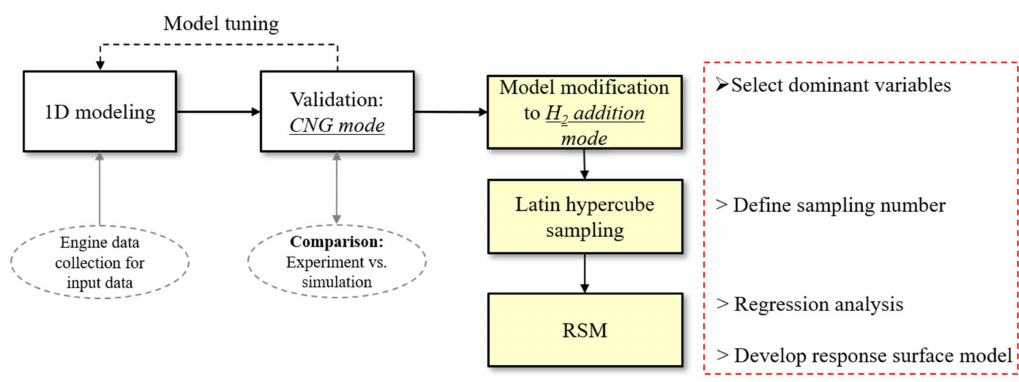
Figure 1. Overall research